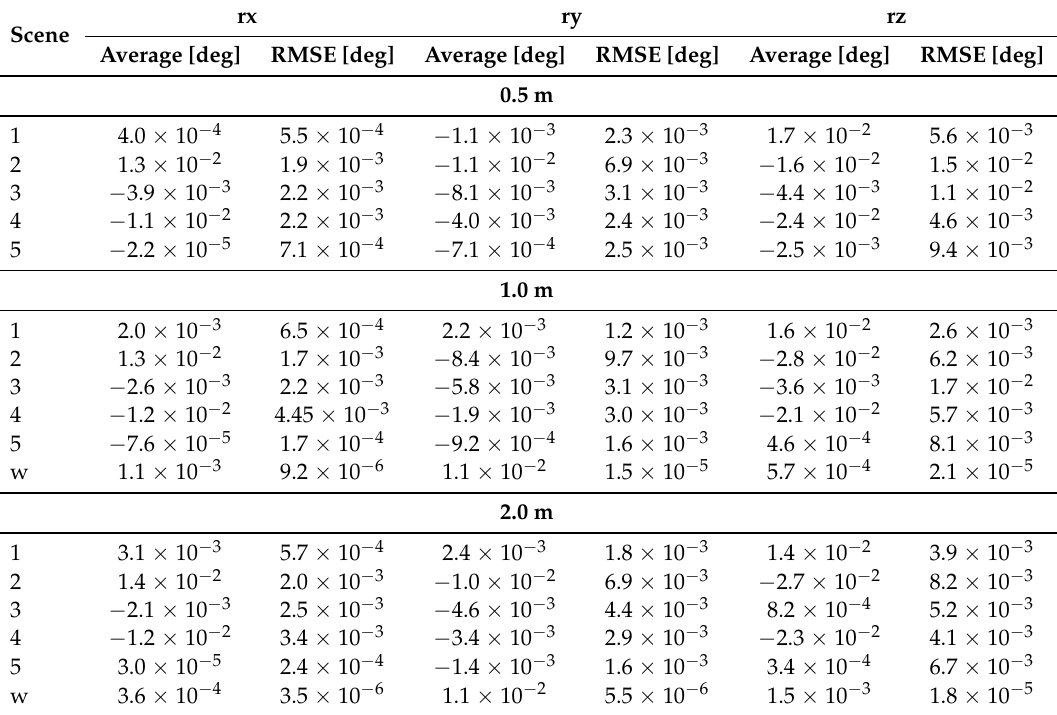
Table 2. Results of the scenes with Point Cloud GSD: 0.5m and grid size: 1 m